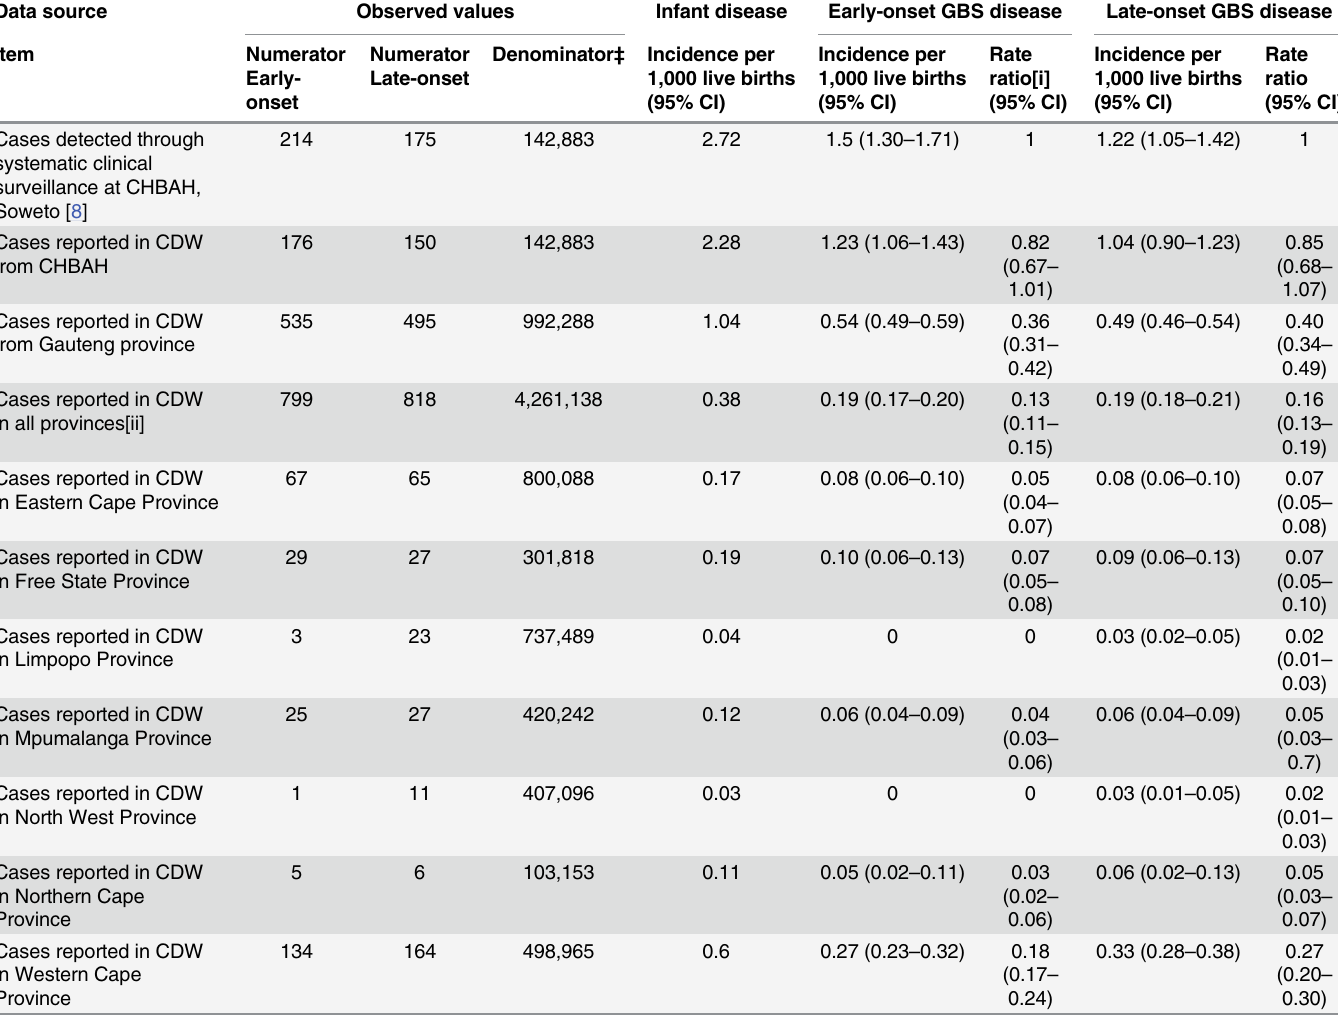
Table 1. Estimates of incidence of early- and late-onset GBS disease and rate ratios and infant disease comparing rates using provincial and over- all CDW reports to real-time clinical surveillance at CHBH, 2004 – 2008. Data